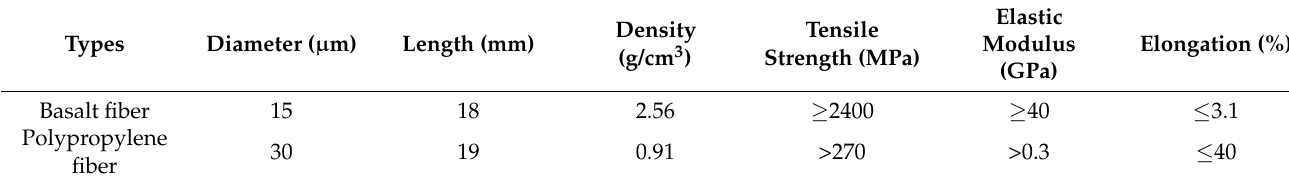
Table 2. Physical properties of gelling materials.